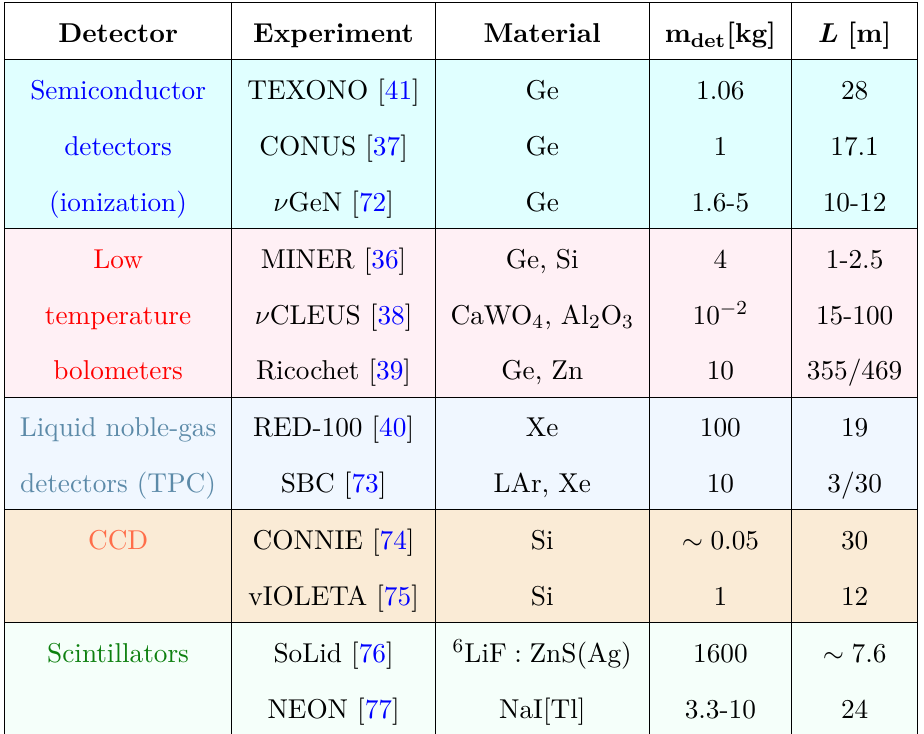
Table 3 . Detectors to which our analysis may apply, along with relevant parameters for ALP de- tection. With germanium as a target material, m = 10 kg and L = 10 m are rather representative det of the experiments our analysis can cover. CCD refers to charge-coupled